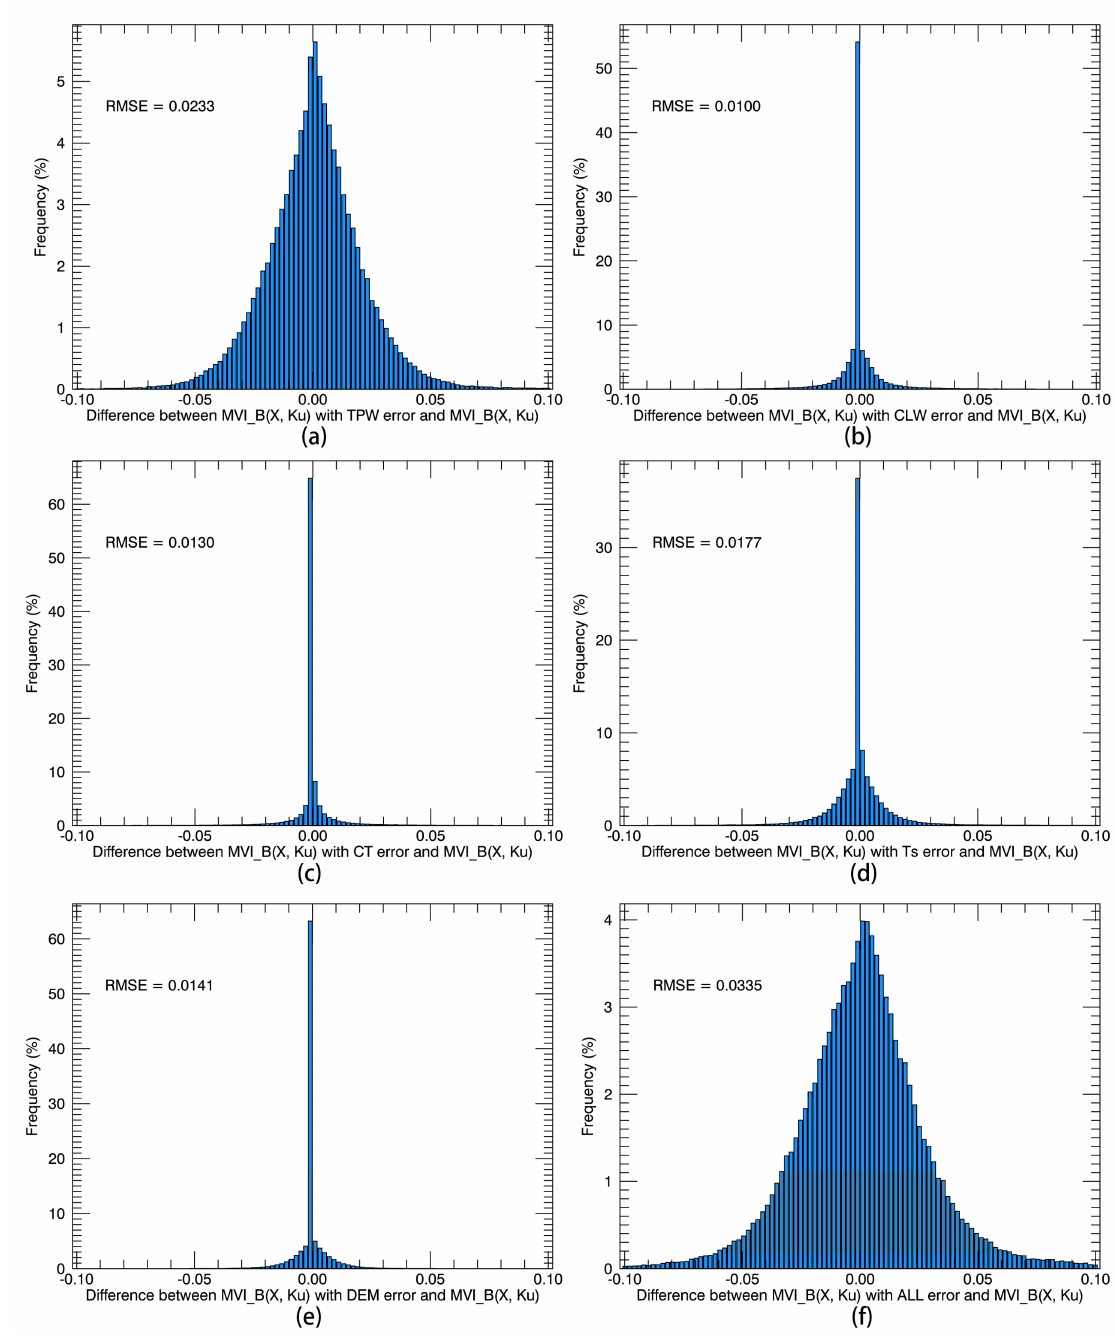
Figure 10. MVI_B (X, Ku) error analysis caused by the uncertainty of input parameters in the atmospheric correction; ( a ) Difference between MVI_B (X, Ku) with TPW error and MVI_B (X, Ku); ( b ) Difference between MVI_B (X, Ku) with CLW error and MVI_B (X, Ku); ( c ) Difference between MVI_B (X, Ku) with CT error and MVI_B (X, Ku); ( d ) Difference between MVI_B (X, Ku) with Ts error and MVI_B (X, Ku); ( e ) Difference between MVI_B (X, Ku) with DEM error and MVI_B (X, Ku); ( f ) Difference between MVI_B (X, Ku) with all parameter errors and MVI_B (X,